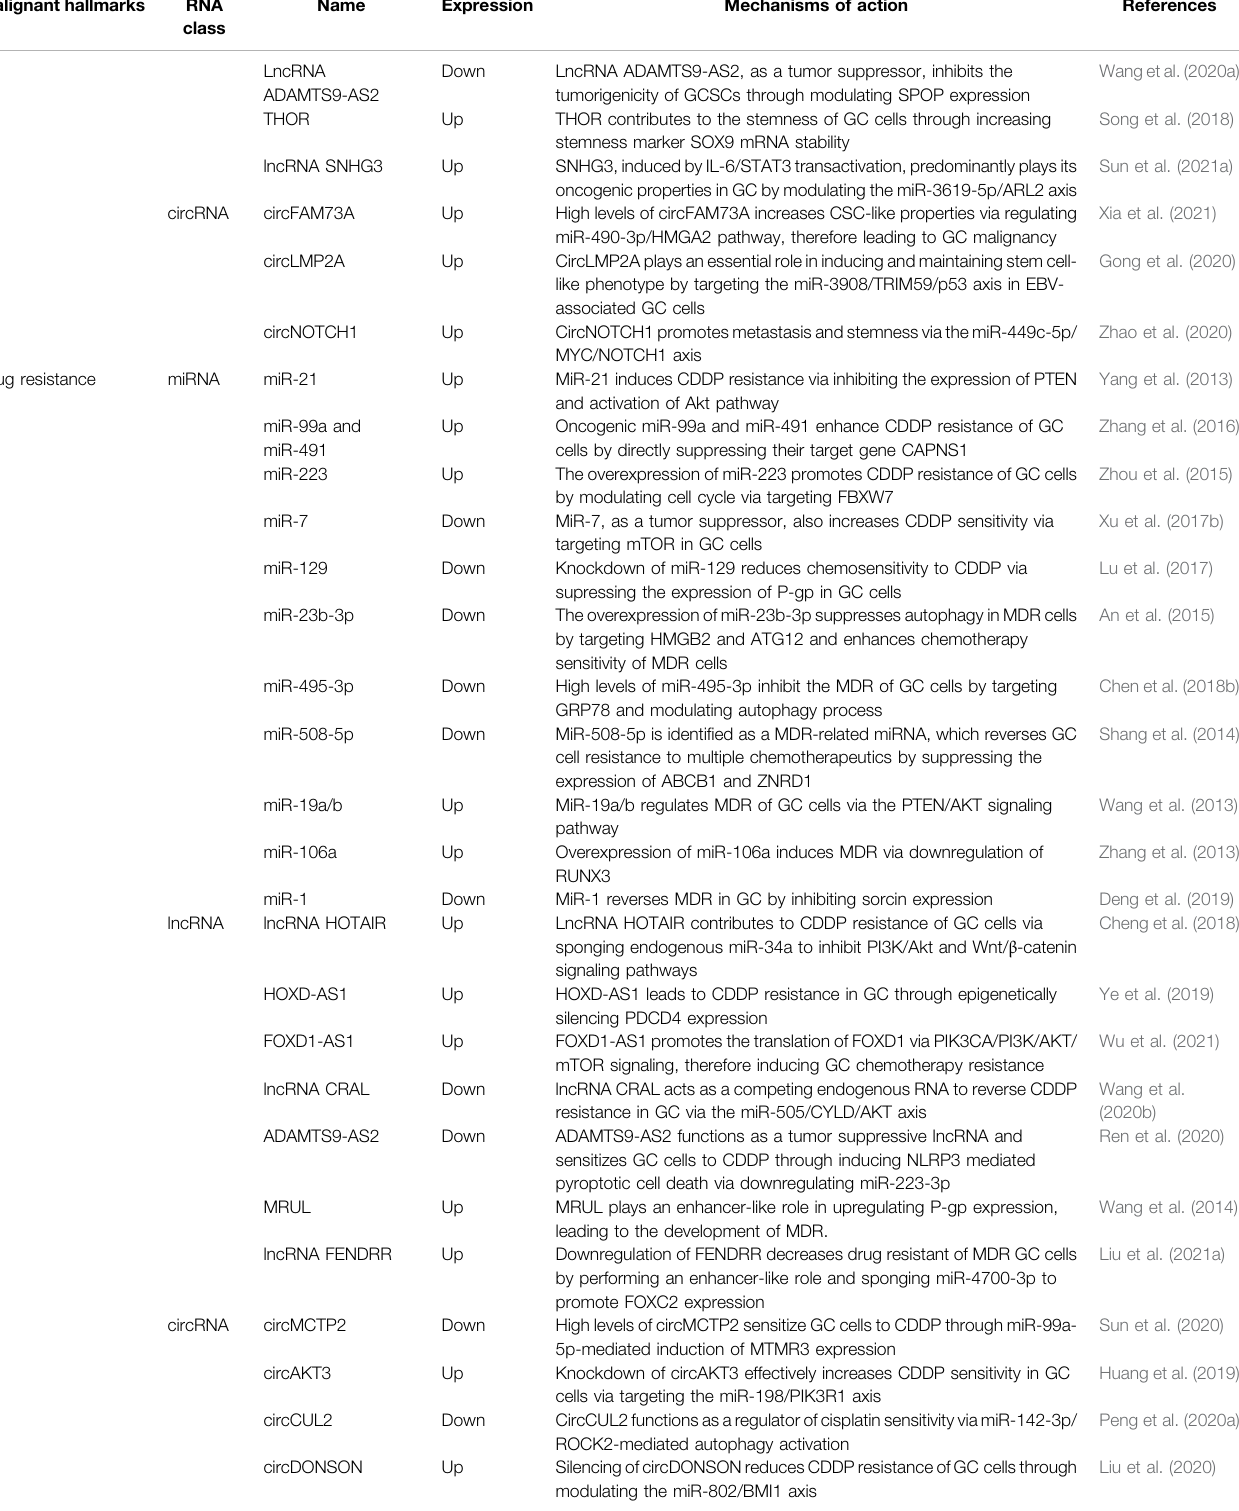
TABLE 1 | ( Continued ) The relationship between ncRNAs and the malignant hallmarks of GC. Malignant